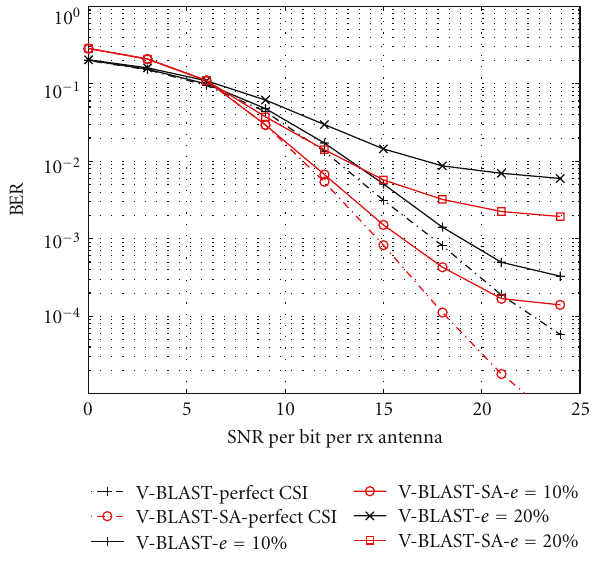
Figure 11: BER versus SNR for V-BLAST, V-BLAST-SA for CSI errors e = 0, e = 10%, e = 20%, N = M = 5, N t = 7, D = 16,